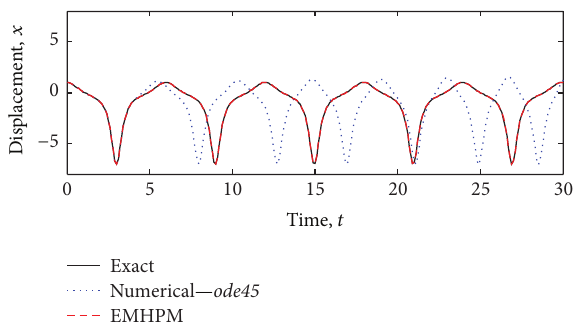
Figure 7: Solution of (31) with Δ𝑡 = 200 ms and 𝑚 = 22 .